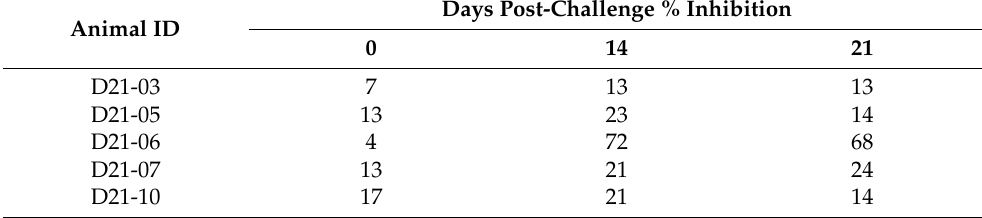
Table 2. Detection of antibodies to FMDV nonstructural proteins utilizing 3B ELISA in post-vac- cination/pre-challenge and post-challenge vaccinated cattle. Positive values categorized as inhibi- tion ≥ 40%.